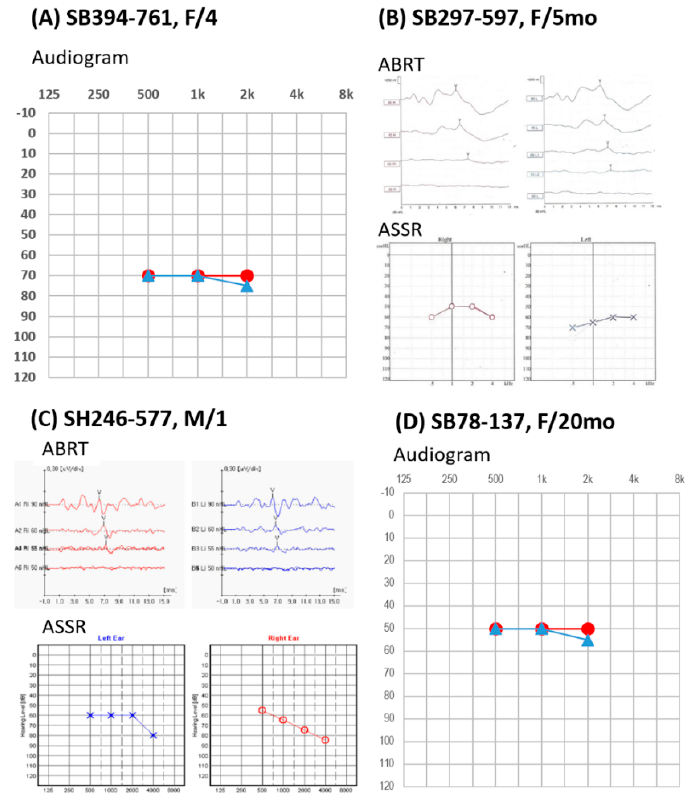
Figure 1. Audiological results of four unrelated families segregating mutations in PDZD7. The horizontal axis shows tone frequency (Hz); the vertical axis gives the hearing level (dB). Symbols “ ● ” and “ ▲ ” denote air conduction pure-tone thresholds at different frequencies in the right (red color) and left ear (blue color). ( A ) For SB394-761 (F/4), non-syndromic severe sensorineural hearing loss (SNHL) was obtained by play audiometry with air conduction at frequency 500 Hz, 1k Hz, and 2k Hz. ( B , C ) For SB297-597 (F/5mo) and SH246-577 (M/1), the response to 55 dB click sounds on both ears and symmetrical moderate-to-severe non-syndromic SNHL were observed in the auditory brainstem response threshold (ABRT) and auditory steady-state response (ASSR), respectively. ( D ) For SB78-137 (F/20mo), non-syndromic SNHL was obtained by play audiometry with air conduction at frequency 500 Hz, 1kHz, and 2kHz.